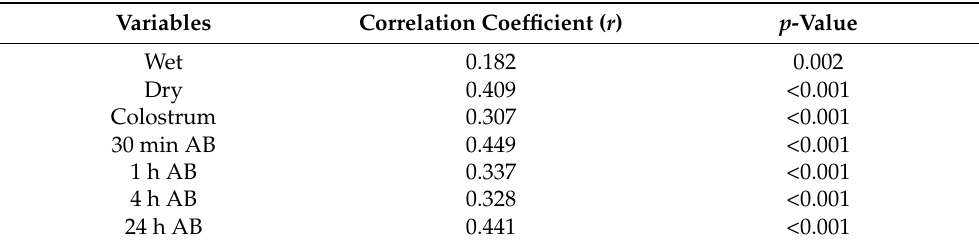
Table 12. Significant correlations between puppies’ weight and their superficial temperature at T thermal